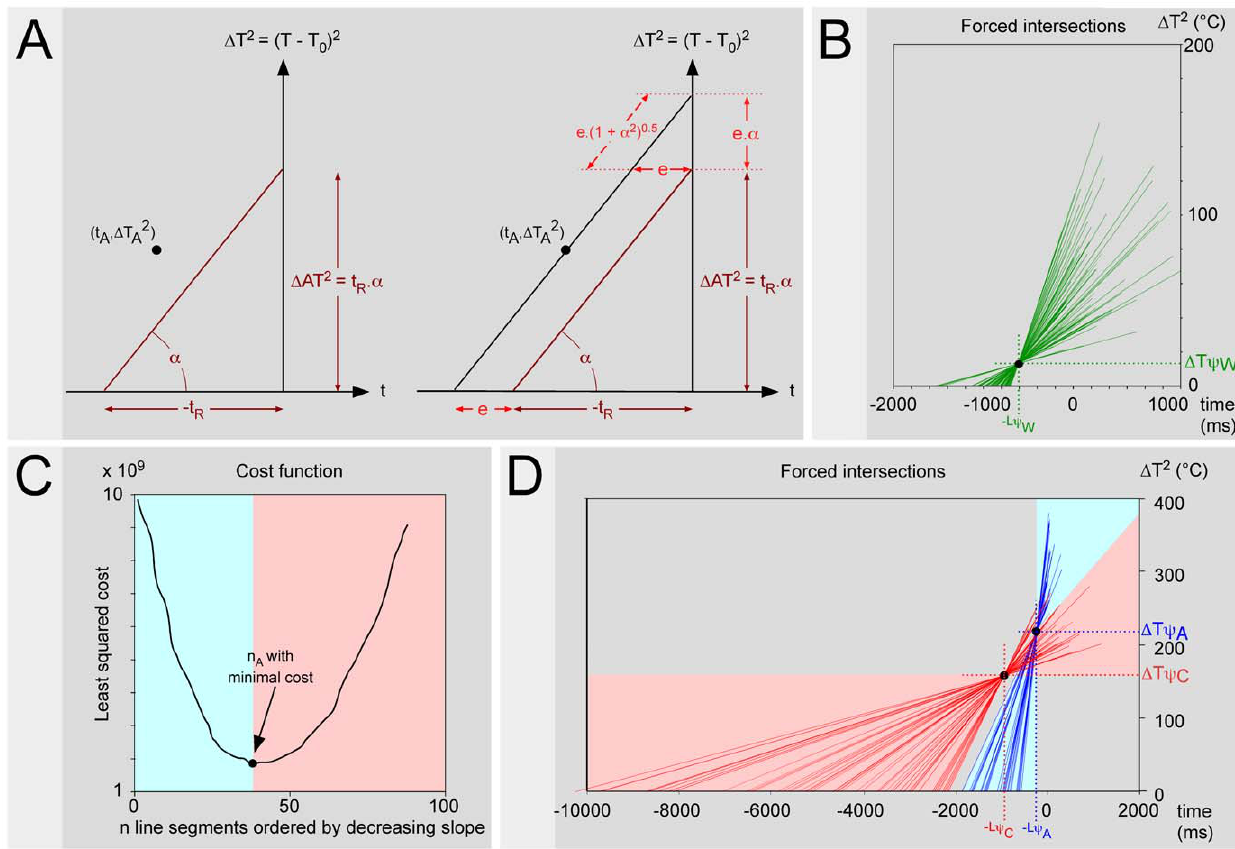
Figure 13. Computation of the psychophysical threshold T y , latency L y and the limit slope a AC by a procedure based on a weighted least squares minimization criterion. - A Principle of forced intersections (see text). - B Determination of the point of forced intersections for the ‘‘warm’’ responses exemplified in figure 5. - C Least squares minimization criterion allowing to determine the limit slope a AC applied to the ‘‘pain’’ responses exemplified in figure 5. - D Determination of the point of forced intersections for the A and C subgroups of psychophysical responses exemplified in figure 5.